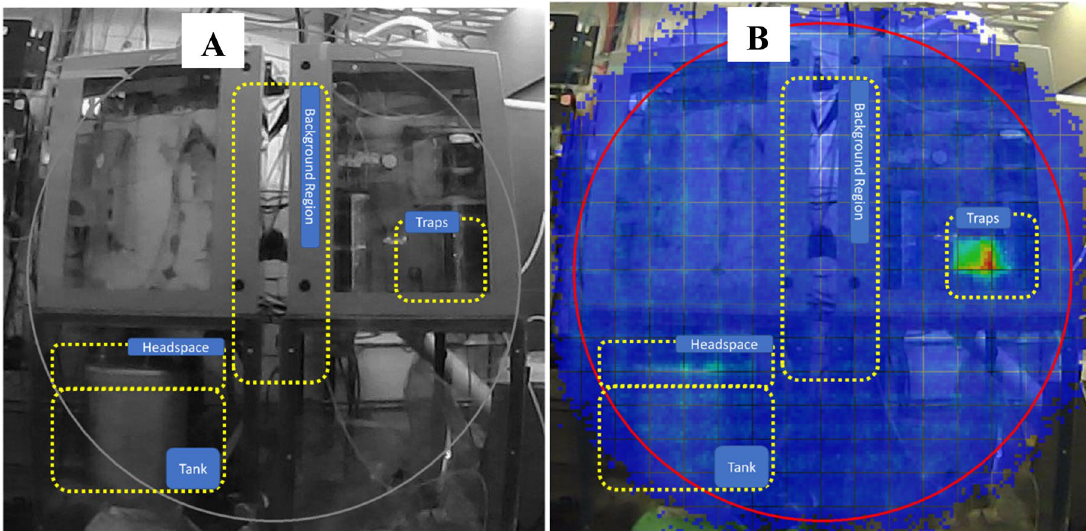
Figure 2. Example of the images collected with the NPI detector of the ( A ) experimental set up and a ( B ) heat map of the radiation produced and collected in the system. The ROIs selected to determine counts of activity in the headspace and the tank, the traps, and background measurements are depicted by the yellow